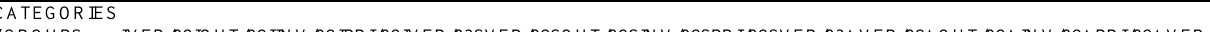
Table 3. Contribution of macroscopic diet categories of D. langei represented by Percentage Composition (CP) and Feeding Index (IA ), comparing the total length (Lt) categories Juveniles (J = Lt < 3 cm), Semi-adults (S = 3 < Lt < 8 cm) and Adults (A i = Lt > 8 cm) and seasons: VER = Summer (December, January and February), OUT = Autumn (March, April and May), INV = Winter (June, July and August) and Spring = PRI (September, October and November). Group codes are: JVER/02 = Juveniles Summer / 2002, JO2 = Juveniles Autumn / 2002, JI2 = Juveniles Winter / 2002, JP2 = Juveniles Spring / 2002, JV3 = Juveniles Summer / 2003, SV2 = Semi-adults Summer / 2002, SO2 = Semi-adults Autumn / 2002, SI2 = Semi-adults Winter / 2002, SP2 = Semi-adults Spring / 2002, SV3 = Semi-adults Summer / 2003, AV2 = Adults Summer /2002, AO2 = Adults Autumn / 2002, AI2 = Adults Winter / 2002, AP2 = Adults Spring / 2002 and AV3 = Adults Summer / 2003. The diet category codes mean respectively: IAU = Autochthonous Insects, IAL = Allochthonous Insects, OAU = Other Autochthonous Arthropods, OAL = Other Allochthonous Arthropods, RANI = Non Identifiable Arthropod Parts, VAU = Autochthonous plants, VAL = Allochthonous Plants, SF = Fruits and Seeds, DT = Detritus and IR = Remaining Items.